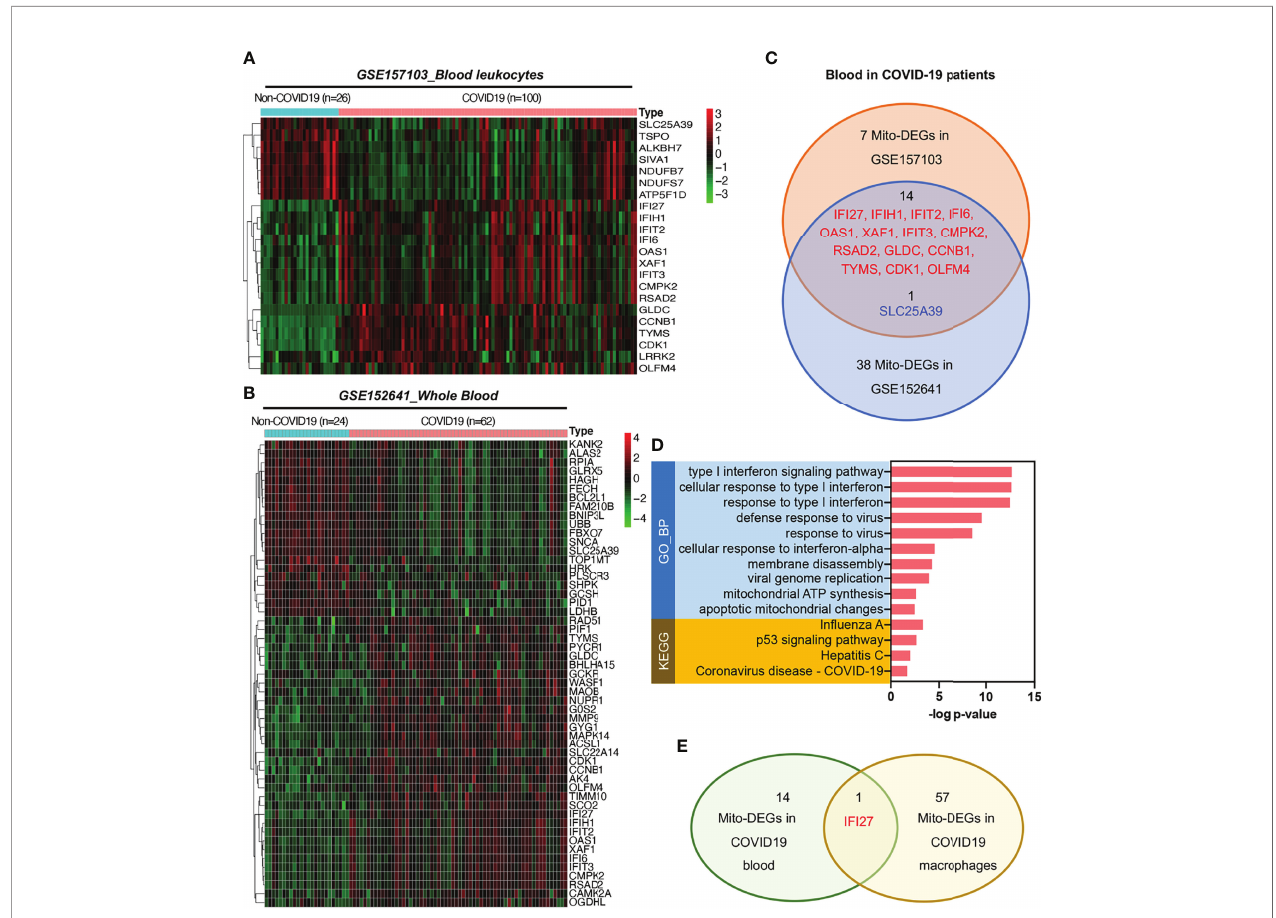
FIGURE 5 | Expression of mitochondrion-related genes in the blood of patients with COVID-19. (A) Heat map of mito-DEGs in blood leukocytes from GSE157103. (B) Heat map of mito-DEGs in the whole blood from GSE152641. (C) Venn diagram showing the intersection mito-DEGs between these two GSE datasets. (D) Functional enrichment analysis of mito-DEGs in blood from patients with COVID-19. GO analysis and KEGG annotation are both listed. (E) Venn diagram showing the intersection mito-DEGs between blood and macrophages in